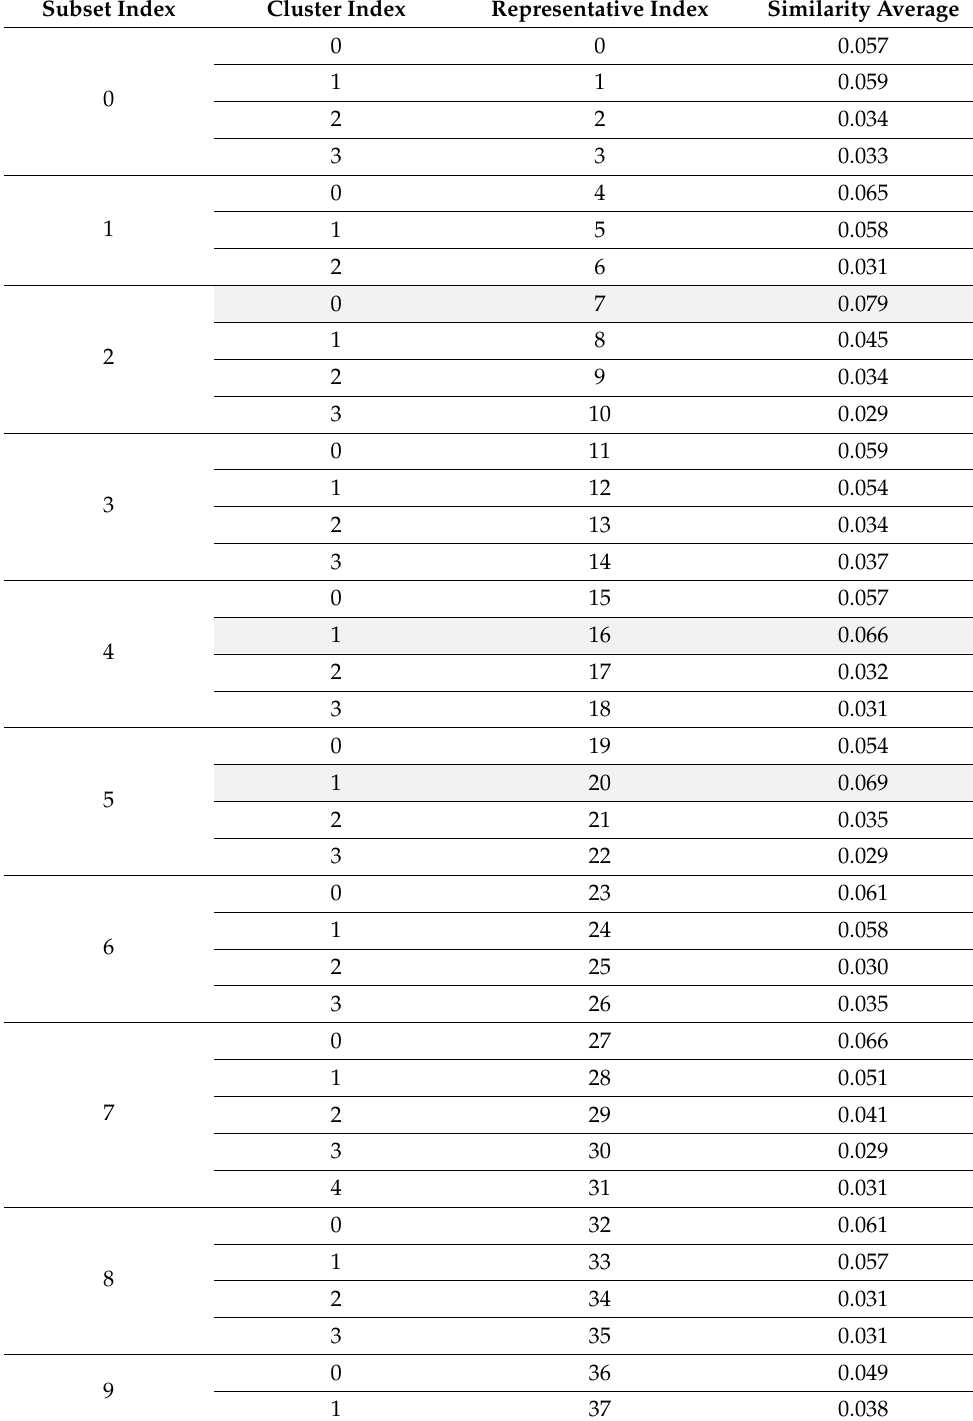
Table 8. Similarity average for each